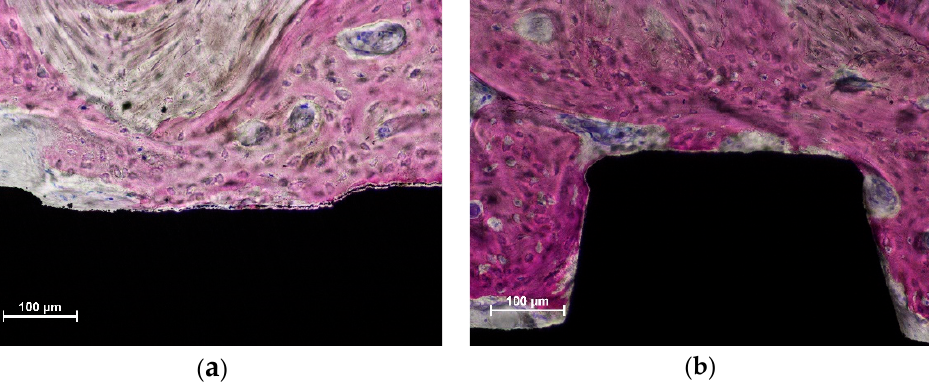
Figure 3. New bone was observed both in the coronal ( a , b ) more apical regions. Acid fuchsine and toluidine blue stain.